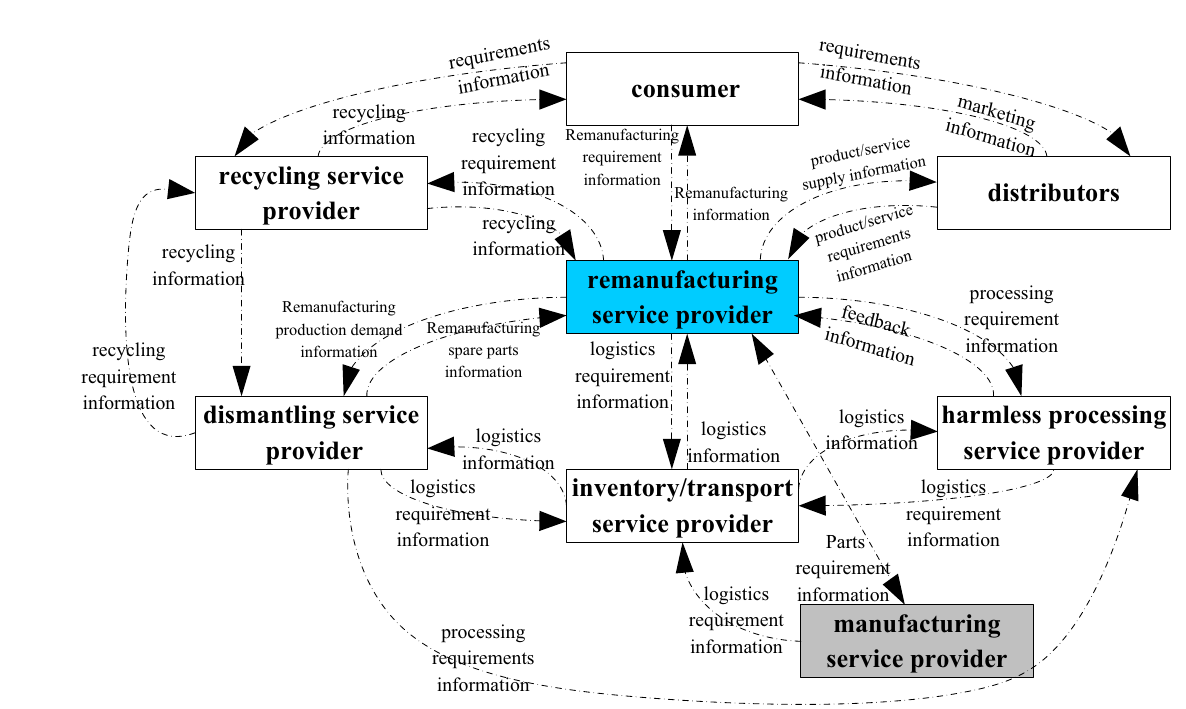
Figure 1 Information flow of remanufacturing service